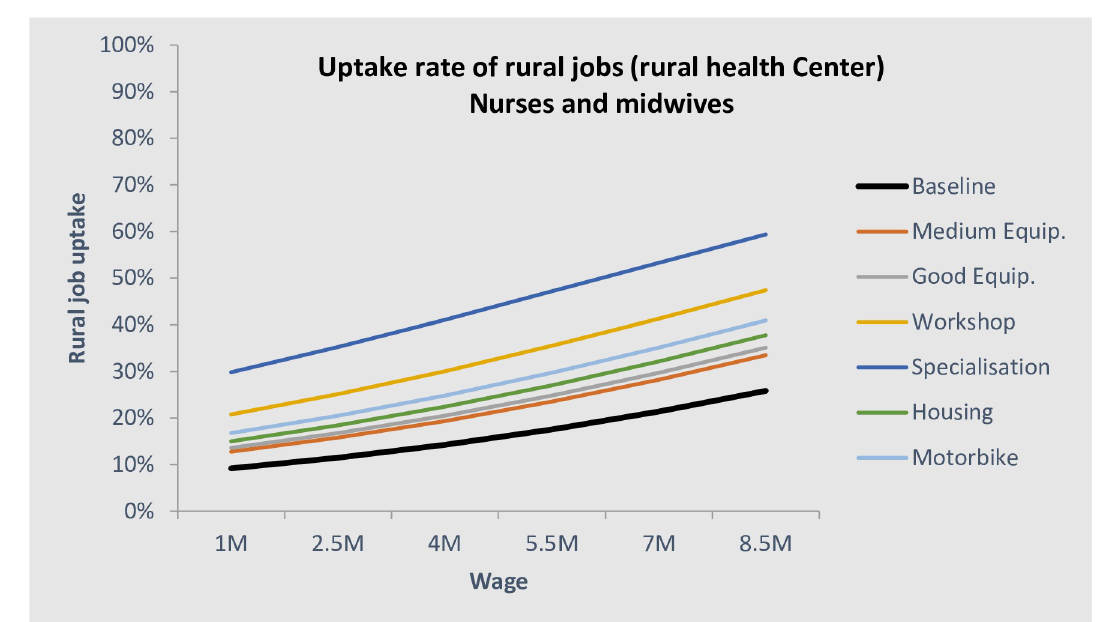
Fig 7. Uptake rate of rural health centre jobs for nurses and midwives.